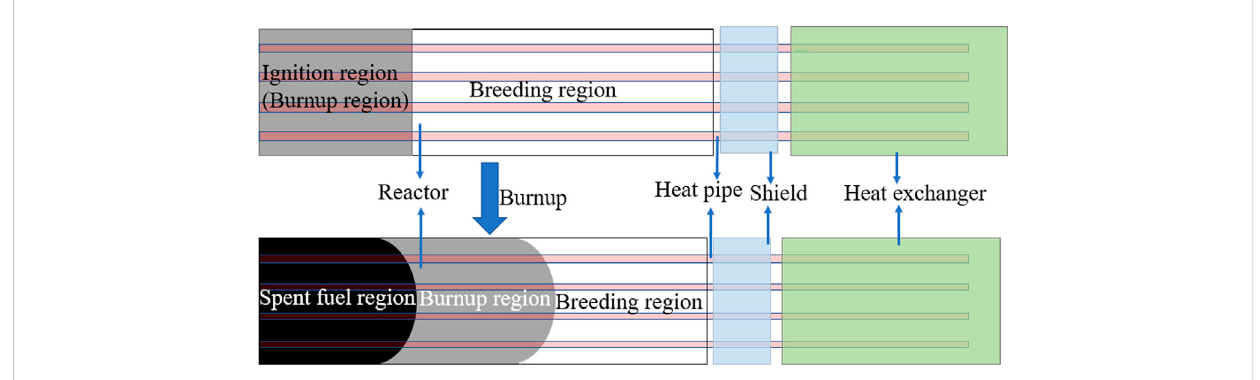
FIGURE 1 Burnup strategy of the heat pipe cooled traveling wave reactor.